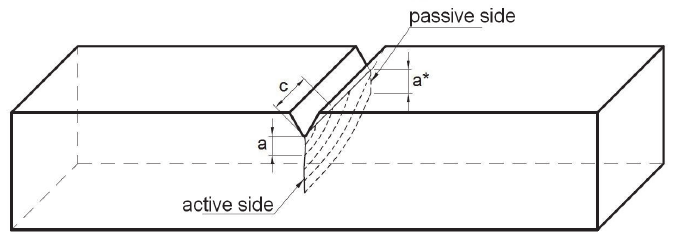
Figure 4: C rack growth under proportional bending with